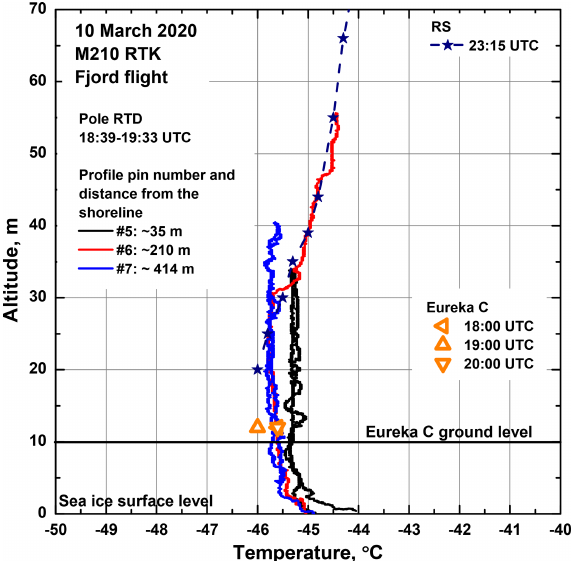
Figure 14. Temperature profiles measured during the M210 RTK fjord flight on 10 March 2020 featuring the SBI over the ice-covered ocean (see Fig. 3 for the locations of the temperature